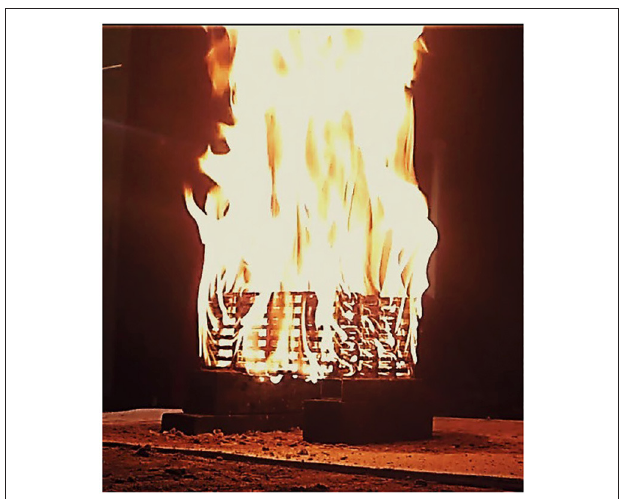
FIGURE 3 | Loosely-packed crib (crib design #11) burning in a quiescent environment showing the entire fuel bed burning uniformly throughout. average standard deviation over all tests was 5.4% of the mean value, with a maximum value of 21.1%, demonstrating good consistency between tests.